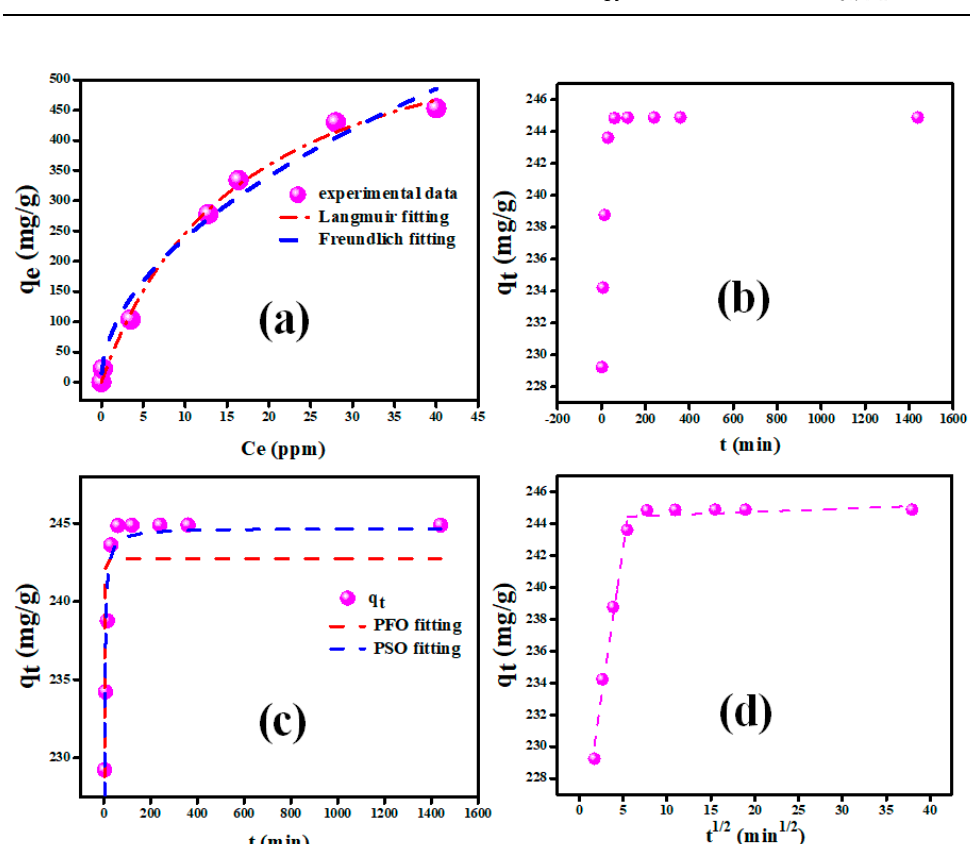
Figure 5. ( a ) Adsorption isotherms modeling, ( b ) contact time e ff ect, ( c ) adsorption kinetics modeling, and ( d ) intraparticle di ff usion of CV adsorption onto the V 2 O 5 -g-C 3 N 4 nanocomposite. Table 1. Equilibrium isotherm constants models for CV dye adsorption by the V 2 O 5 -g-C 3 N 4